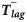
Average lag time between rainfall and runoff Tlag¯.Six potential rainfall durations corresponding to 1, 3, 6, 12,18 and 24 h have been investigated and plotted for extensive (a) and intensive (b) GRs and for RWH (c) tanks. Different symbols and colours represent the nine selected locations.